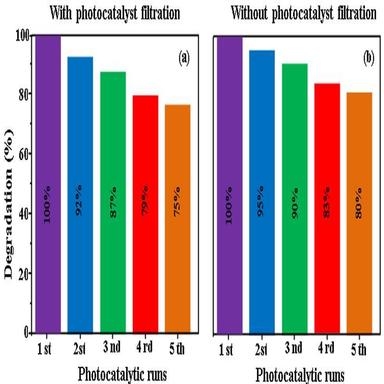
Effects of oxic and anoxic conditions as well as of different scavengers on the reduction efficiency (in terms of NP concentration at time t normalized to the initial concentration at t = 0) by TCF nanocomposite under UV light irradiation.